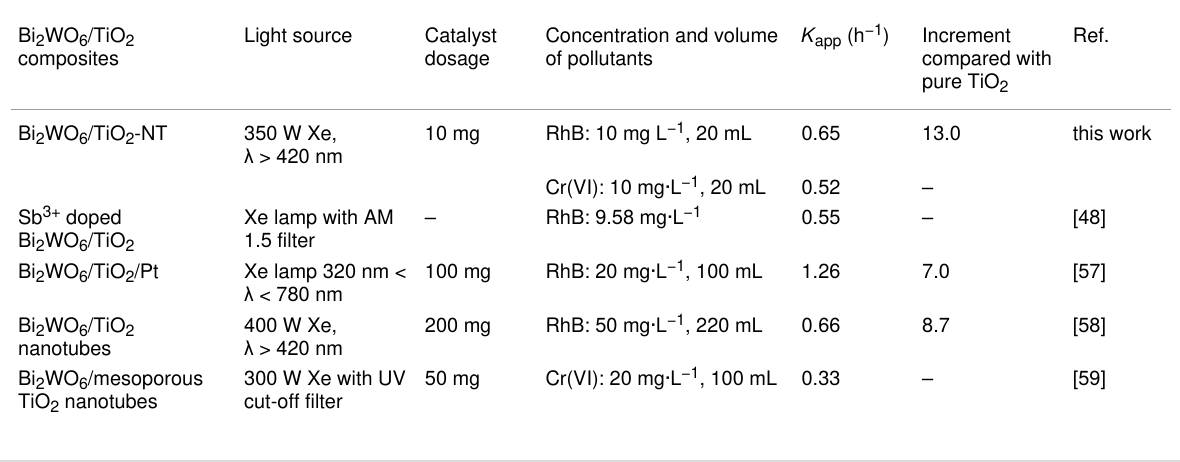
Table 1: Comparison of visible-light-induced ( λ > 420 nm) photocatalytic performances toward the degradation of RhB or reduction of Cr(VI) with other reported Bi 2 WO 6 /TiO 2 composites in the